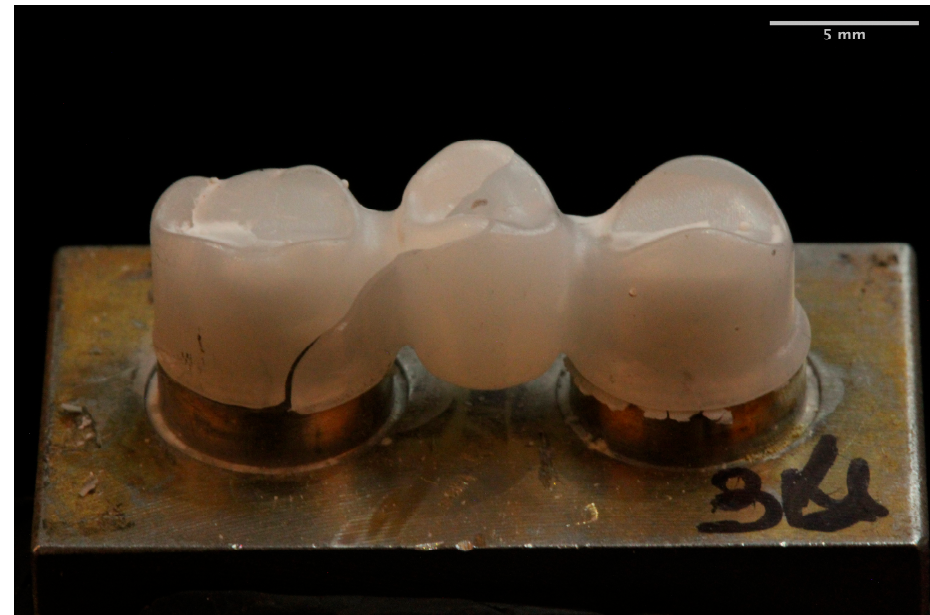
Materials 2021 , 14 , 959 Figure 4. Zirconia framework fracture. Figure 4. Zirconia framework fracture.